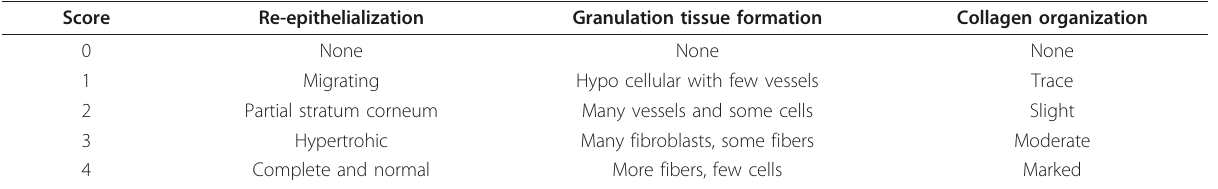
Table 2 Score of historical